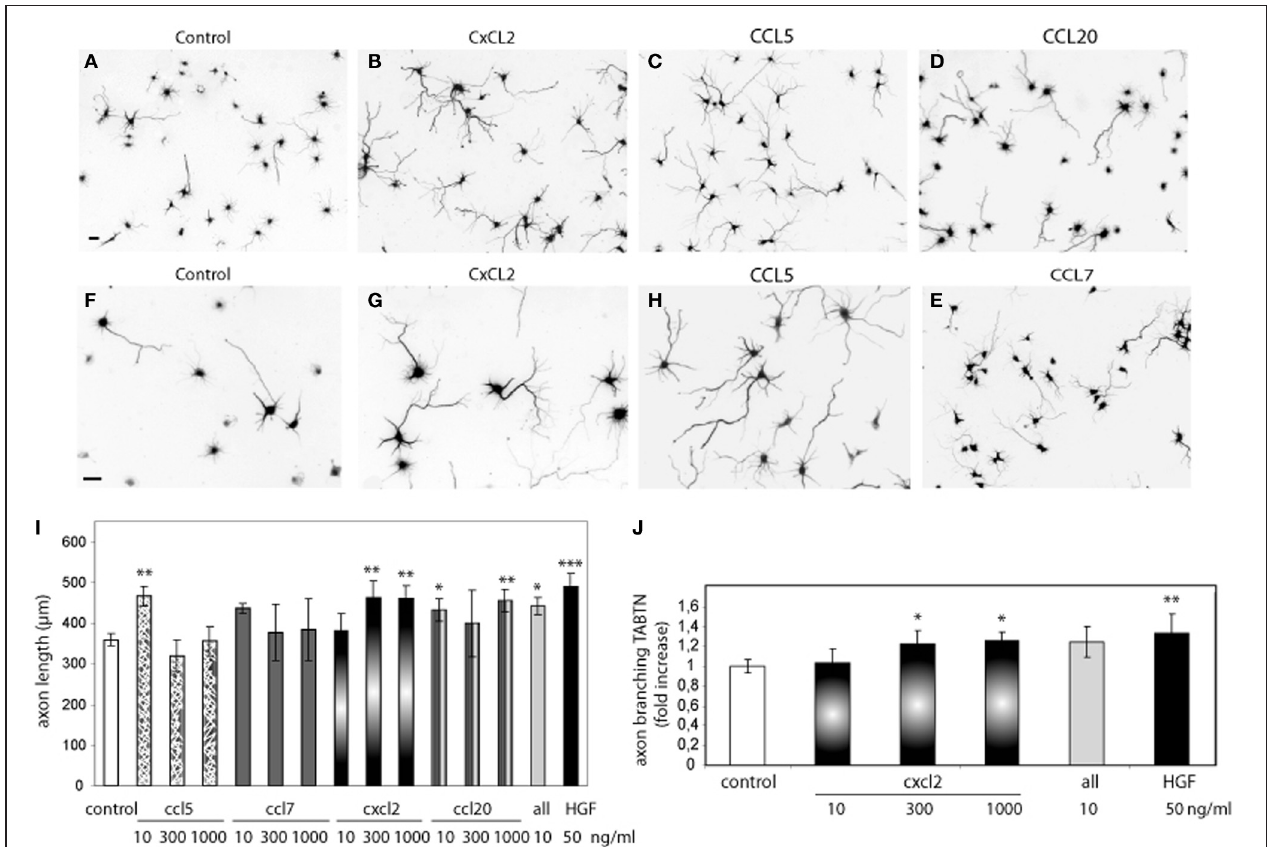
FIGURE 2 | Recombinant chemokines increase axon morphogenesis. (A–H) Hippocampal neurons (2DIV) control or treated with CXCL2, CCL5, CCL20, and CCL7 (1000ng/ml) and immunostained for β III-tubulin to reveal the axon morphology. Images (A–E) were taken at 10 × and (F–H) at 20 × .